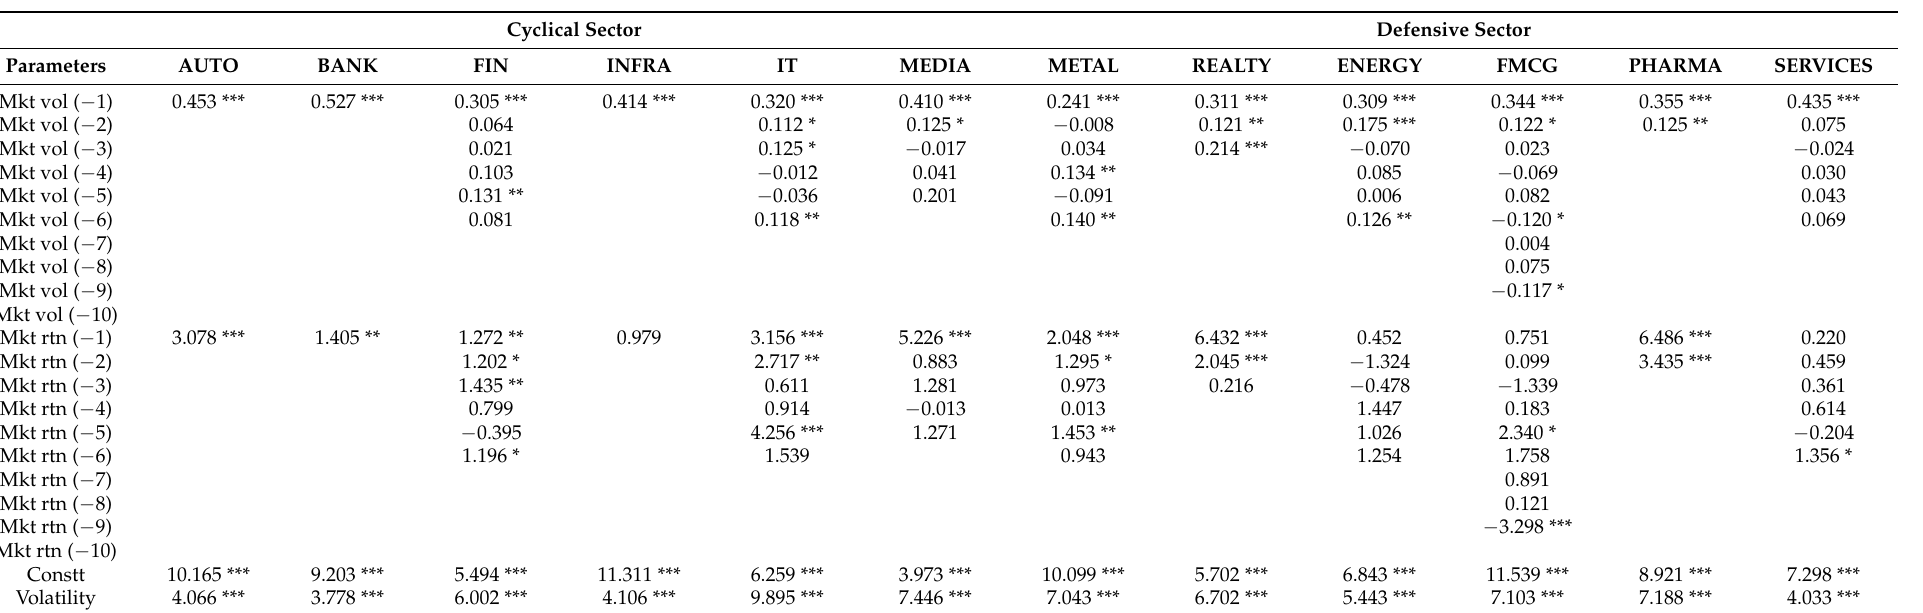
Table 3. VAR result for COVID-19